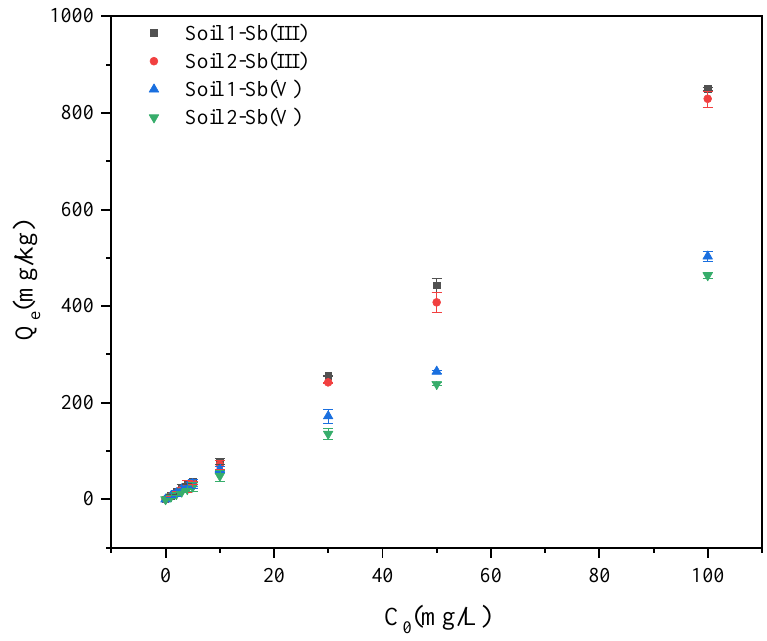
Figure 2. Variation of Sb adsorption on soil with initial concentration.